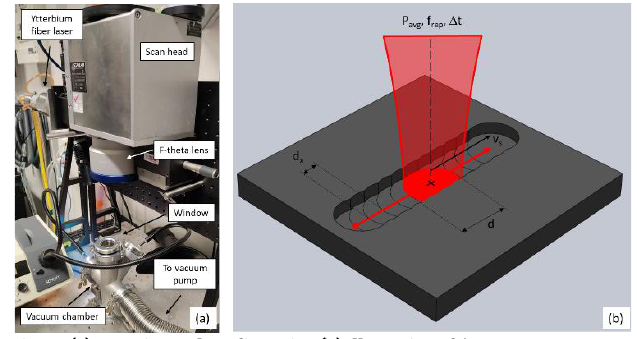
Fig. 1. (a) Experimental configuration (b) Illustration of the process parameters involved during laser